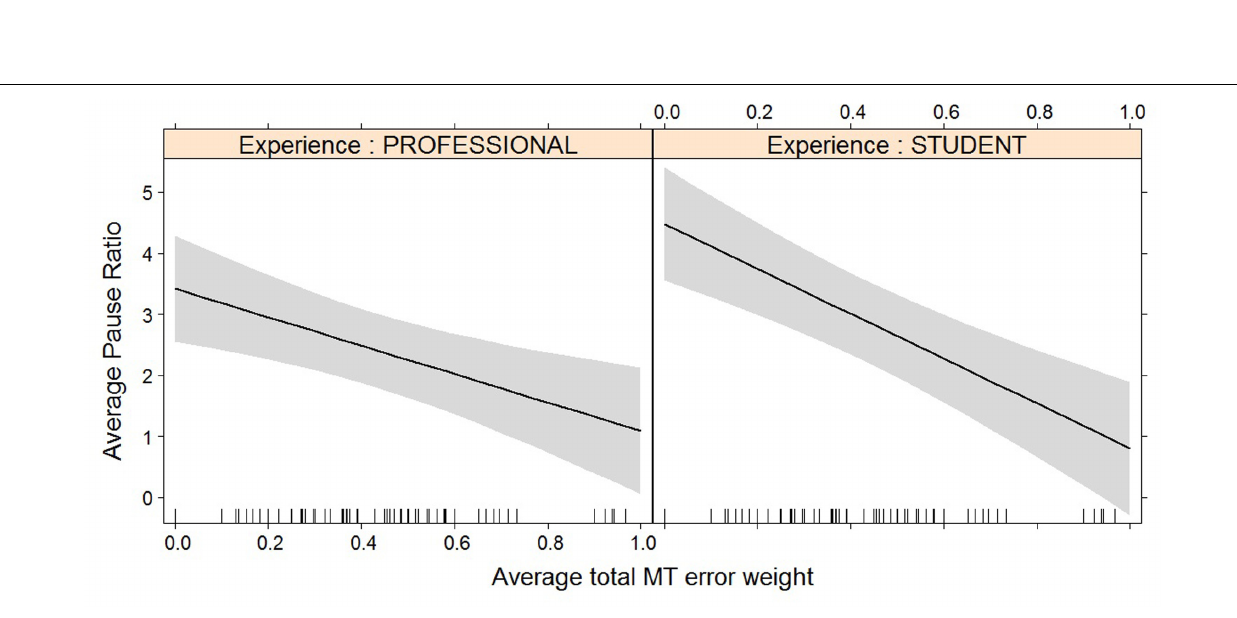
FIGURE 6 | Effect plot of total MT error weight on average pause ratio. An increase in average total MT error weight leads to a decrease in average pause ratio, for professionals and students